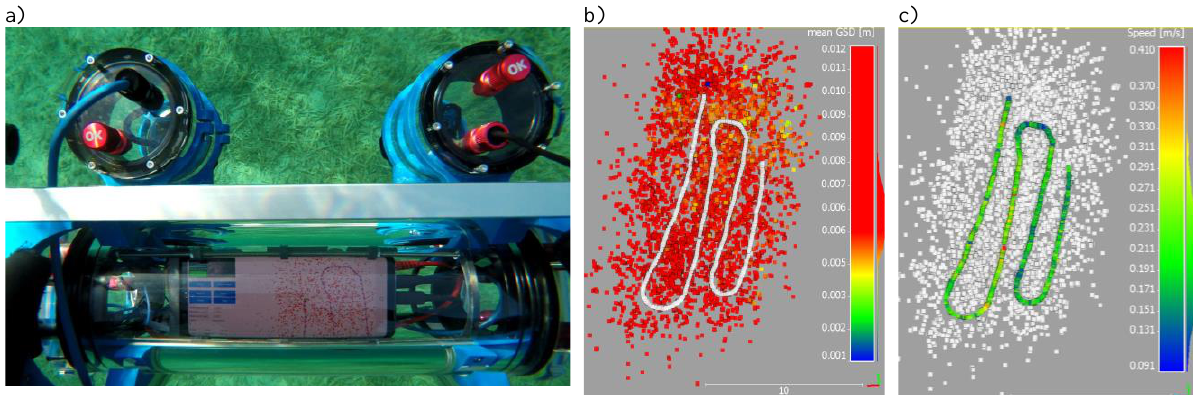
Figure 9. Outputs of the VSLAM process in real time useful for quality check. Trajectory of an underwater survey over seagrass meadow (Posidonia Oceanica) as seen by the diver while being recorded in real-time (a) and corresponding sparse point cloud coloured according to the average GSD (b) or according to the swimming speed (c) for motion blur analysis.